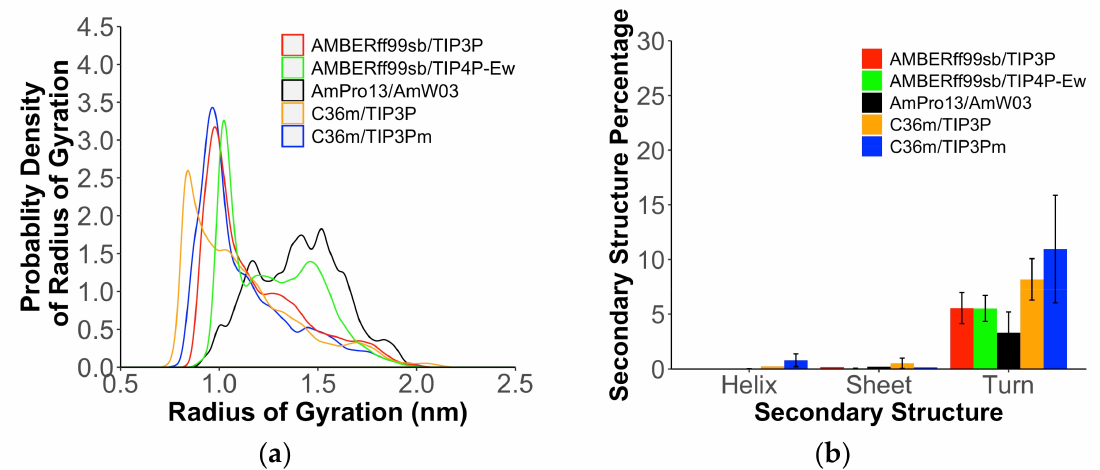
Figure 4. Structural properties for Hst 5 using polarizable and nonpolarizable force fields. ( a ) Probability density estimates of the radius of gyration and ( b ) average percentages of different secondary structures features for the disordered Hst 5